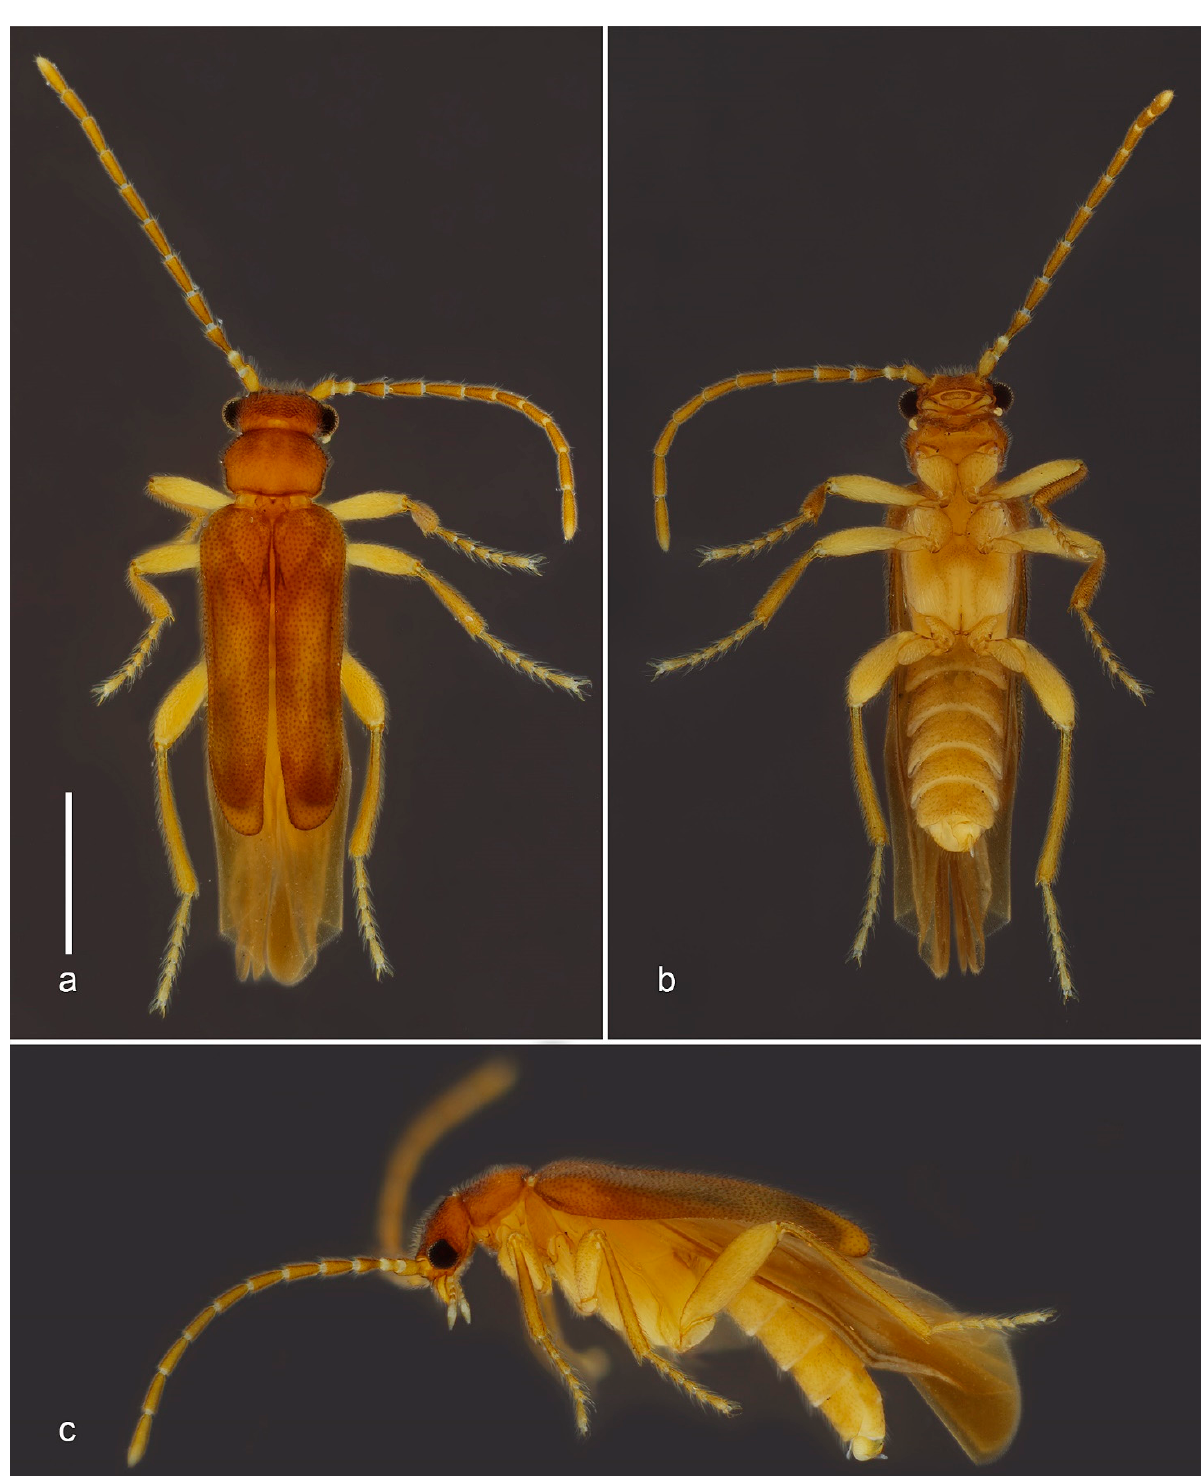
Figure 5. Jurasai digitusdei Rosa, Costa, Kramp and Kundrata, 2020, specimen from Núcleo Santa Virgínia, São Paulo state, habitus. ( a ) Dorsal view; ( b ) ventral view; ( c ) lateral view. Scale bar = 1.0 mm.